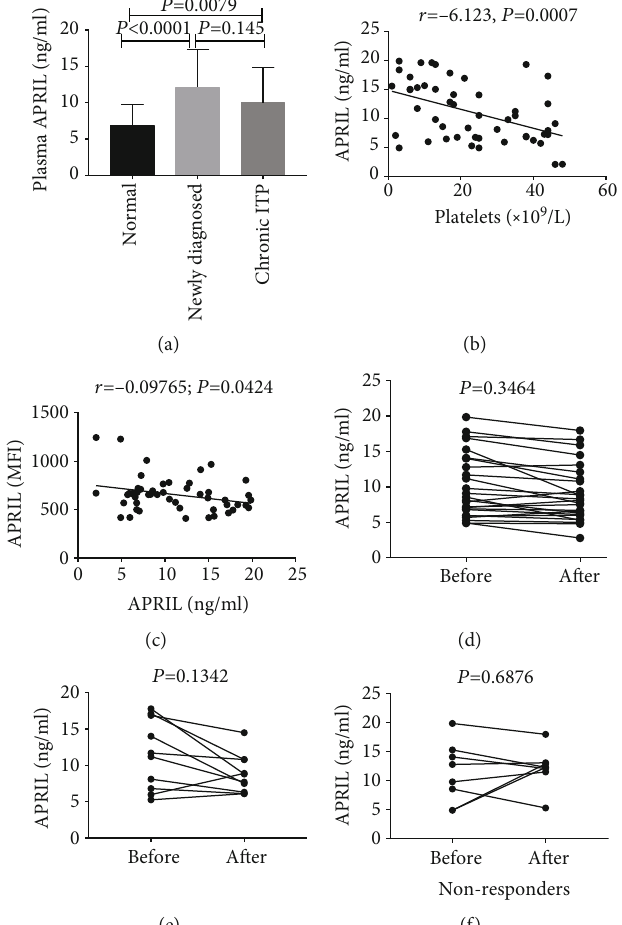
Figure 3: Plasma APRIL levels in ITP patients. (a) Plasma APRIL levels were higher in chronic and newly diagnosed ITP patients than in normal controls ( n = 25 per group), with no signi fi cant di ff erence between the two patient groups. (b) APRIL concentration was negatively correlated with platelet count in ITP patients ( n = 50 ). (c) Correlation between platelet surface APRIL and serum APRIL levels in ITP patients. (d – f) Di ff erences in Plasma APRIL levels before and after treatment in the chronic ITP patient group ( n = 25 ) (d) in the complete remission group ( n = 10 ) (e) and the nonresponse group ( n = 8 )